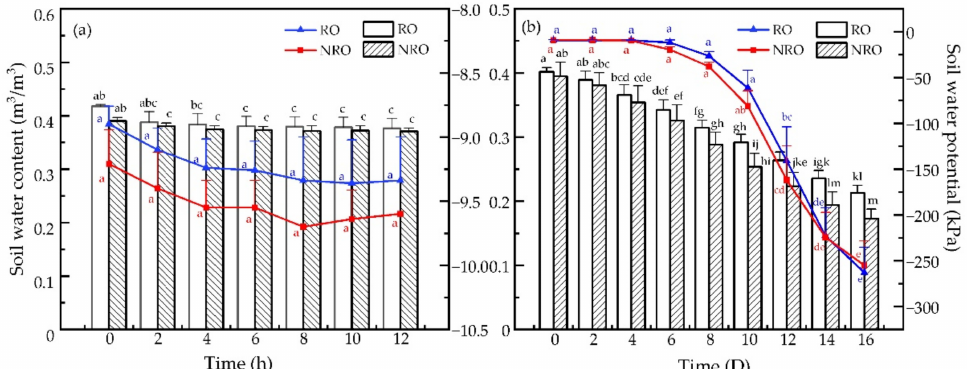
Figure 3. Diurnal and day-to-day variations in the soil water content and water potential in two habitats. ( a ) Diurnal variation of soil water content and soil water potential under drought conditions. ( b ) Day-to-day variation of soil water content and soil water potential under drought conditions. The bar graph and line graph represent the soil water content and soil water potential, respectively. Small letters indicate significant differences at 5% level p < 0.05